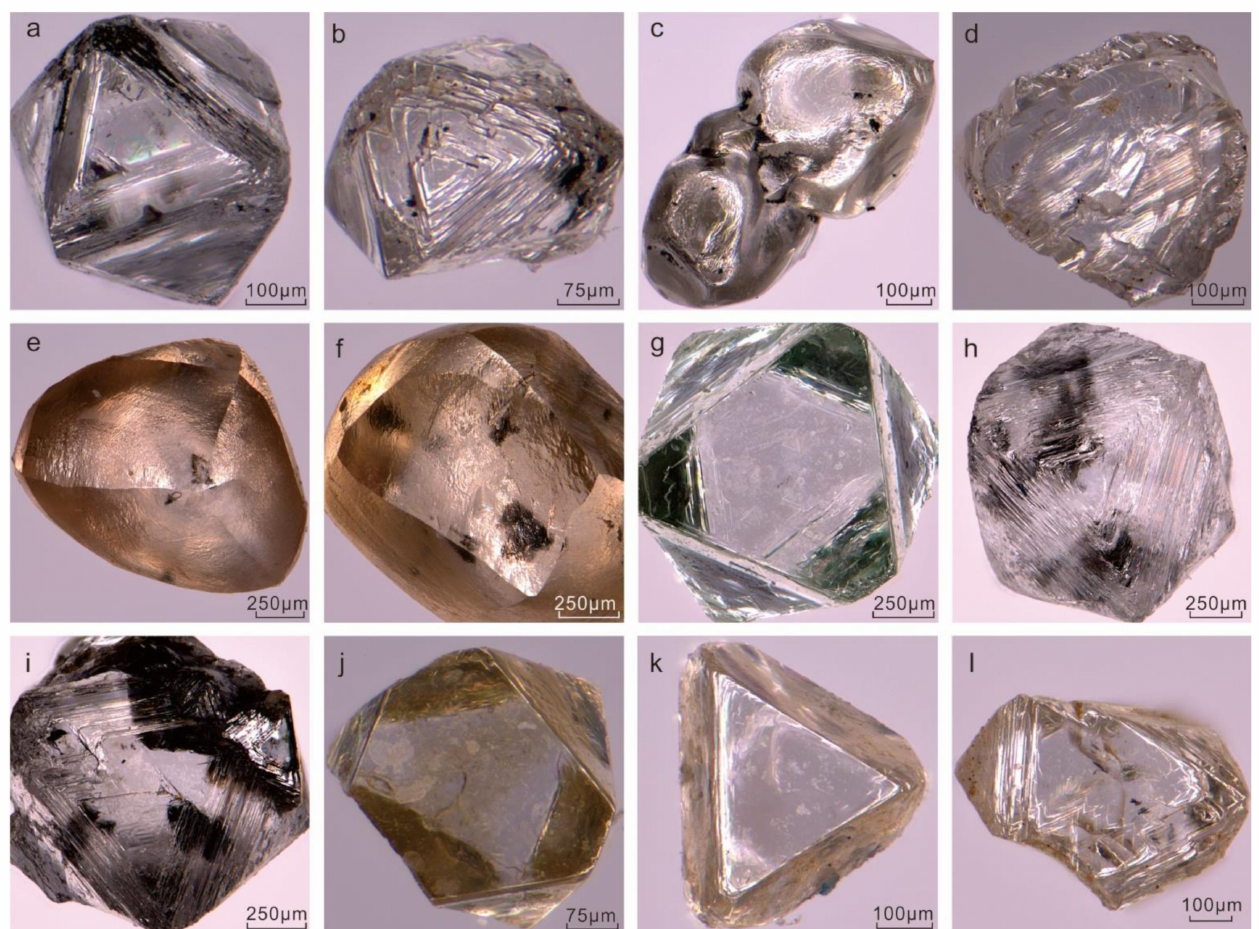
Figure 2. Microscopic 3–D pictures of diamonds in the three belts showing internal texture, surface features and inclusions. ( a ) Changmazhuang (SL-1) diamond, triangular plates; ( b ) Changmazhuang (SL-2), peak cluster triangular hill; ( c ) Changmazhuang, (SL-3) terraces; ( d ) Changmazhuang (SL-7), deformation lines; ( e ) Changmazhuang (HQ27-2), Drop-shaped hillocks; ( f ) Changmazhuang (HQ27- 3), imbricated etched figures; ( g ) Xiyu (HQ23-2), flat-bottomed trigons; ( h ) Xiyu (HQ23-13), triangular plates; ( i ) Xiyu (HQ23-15), peak cluster triangular hill; ( j ) Poli (35T10-2), octahedral fragment; ( k ) Poli (Q29-1), triangular plates; ( l ) Poli (QPL-2), few flat-bottomed